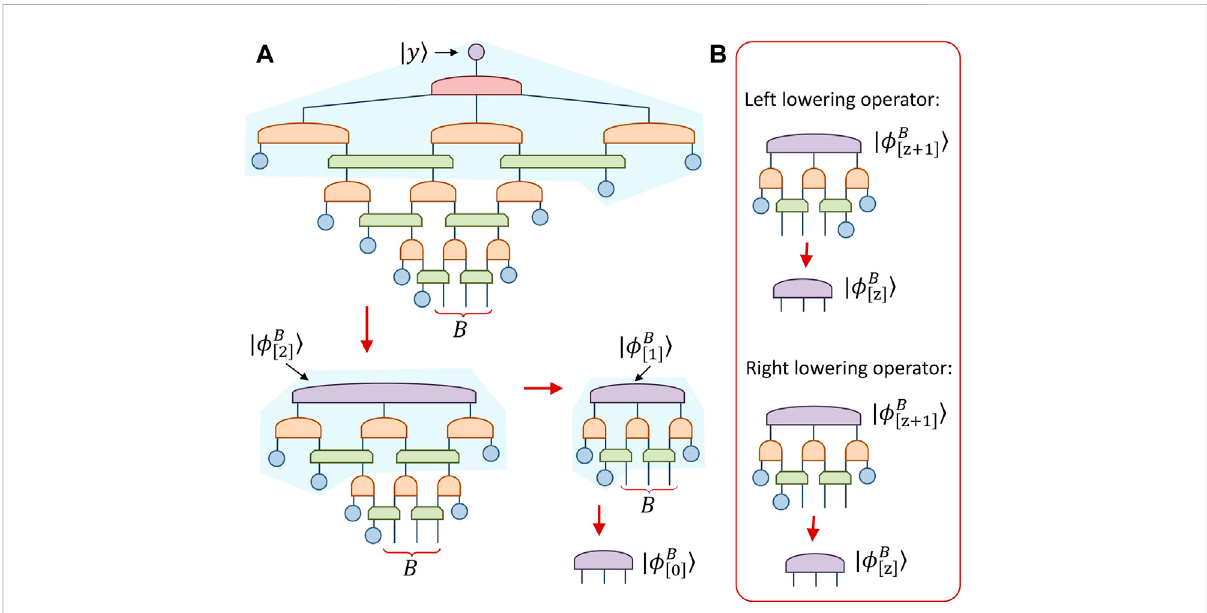
FIGURE 6 (A) Sequence of contractions used to evaluate the con fi guration space | ϕ B [ 0 ] 〉 associated to region B , starting from the causal cone C ( B ) as depicted in Figure 5B. At each step in the evaluation the tensors in shaded region are contracted into a single tensor. (B) For any region B of